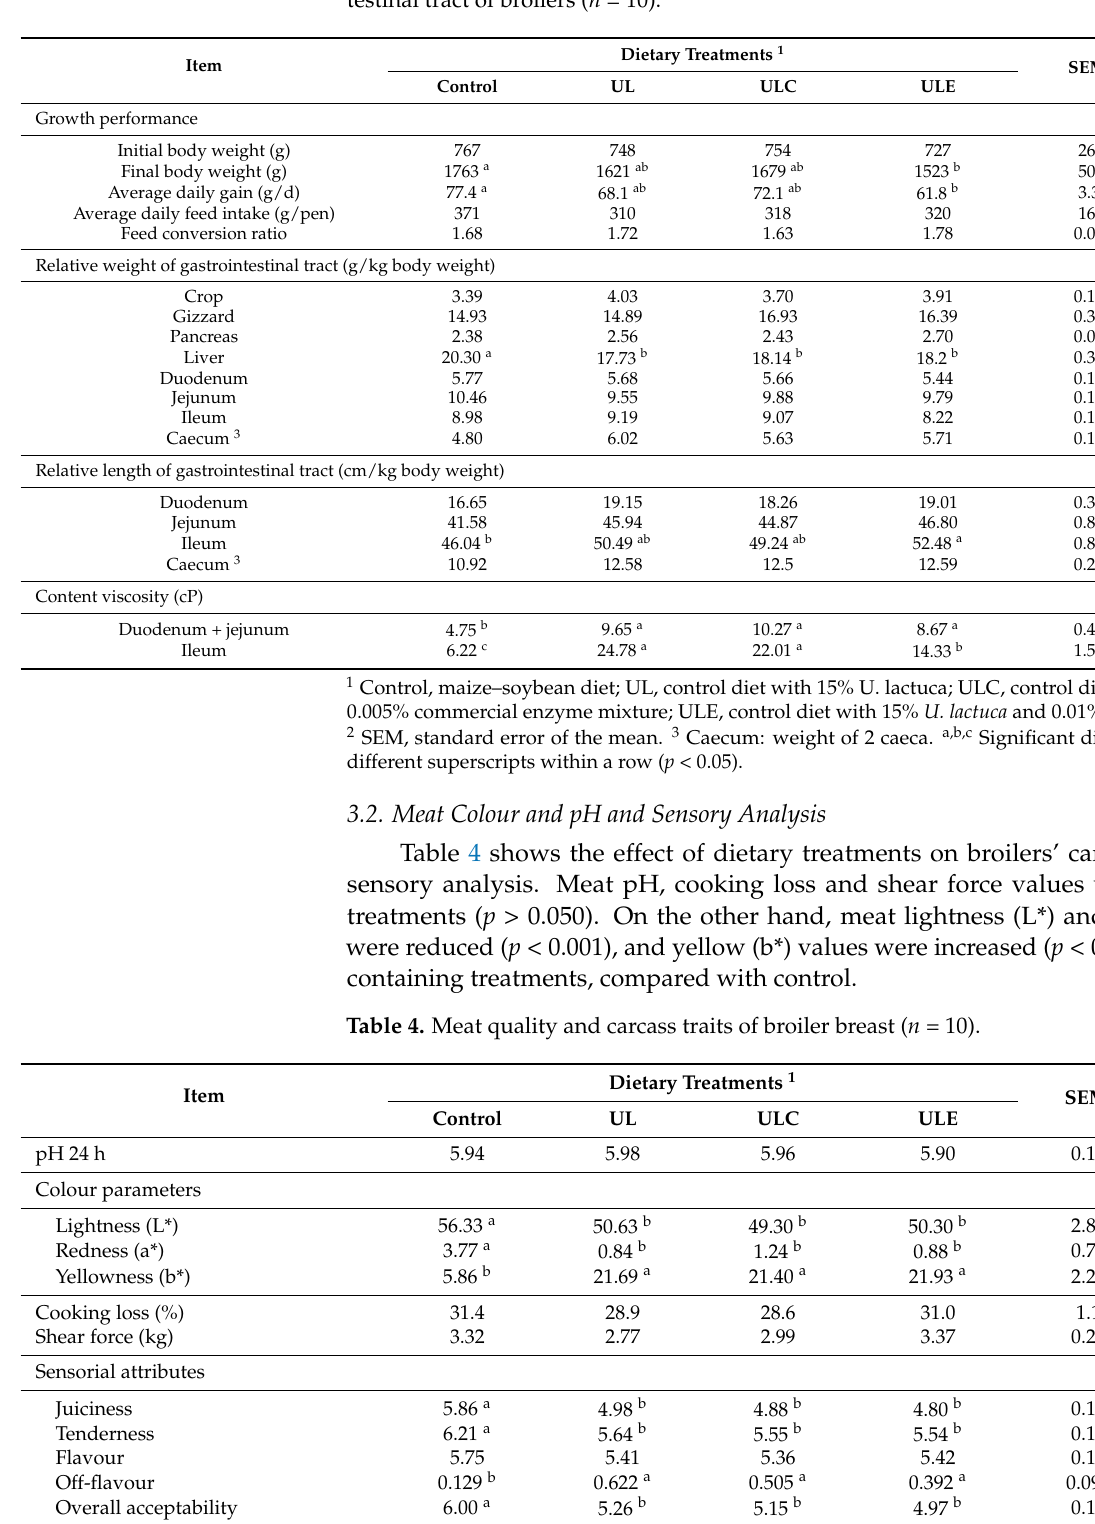
Table 3. Growth performance for days 21 to 35, and weight, length and content viscosity of gastroin- testinal tract of broilers ( n = 10).